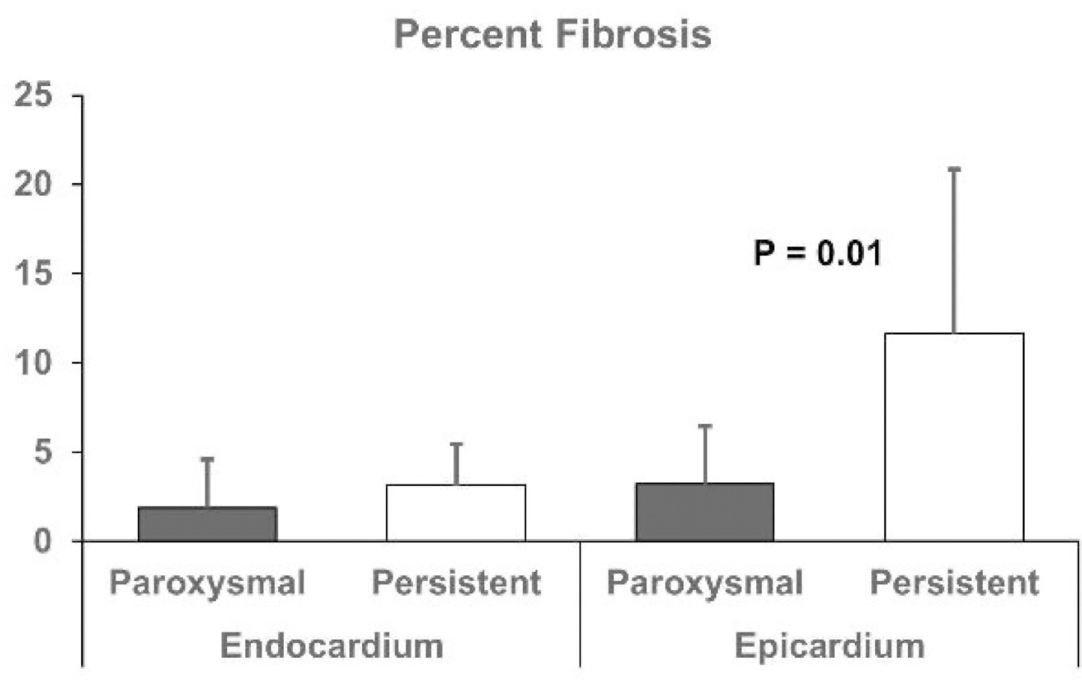
Fig 7. Persistent AF causes increased epicardial fibrosis. Analysis of Masson’s-Trichrome stains revealed a significant increase in epicardial fibrosis.